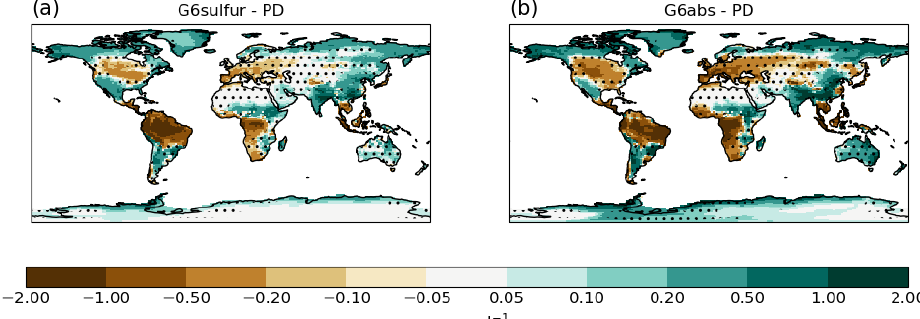
Figure 4. The spatial distribution of the change in the precipitation distribution in the period 2081–2100 compared to PD for (a) G6sulfur and (b) G6abs. Note that the values quoted for the means are for land areas only; global means without the land mask are + 0.048mmd − 1 for G6sulfur and − 0.023mmd − 1 for G6abs. Stippling represents areas that are not significant at the 5% level using a two-tailed t -test.